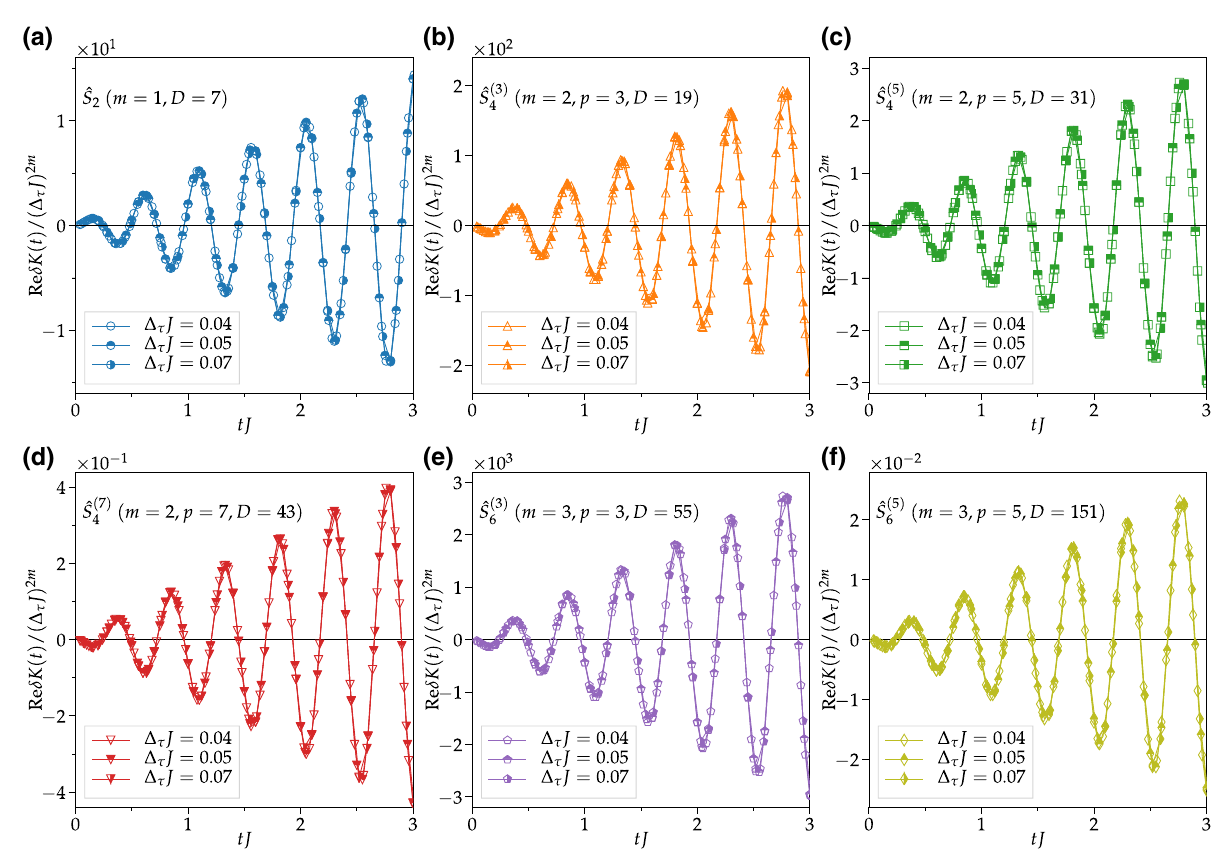
FIG. 18. Same as Fig. 17 but for the Fermi-Hubbard model on a square lattice with a 4 × 2 cluster under open boundary conditions ˆ H in Eq. (B6). The other parameters of the model are U H / J = 4 and N = 16 at half filling. N (cid:5) = 4 and described by the Hamiltonian = 0.04, 0.05, and 0.07 are (cid:3) τ J